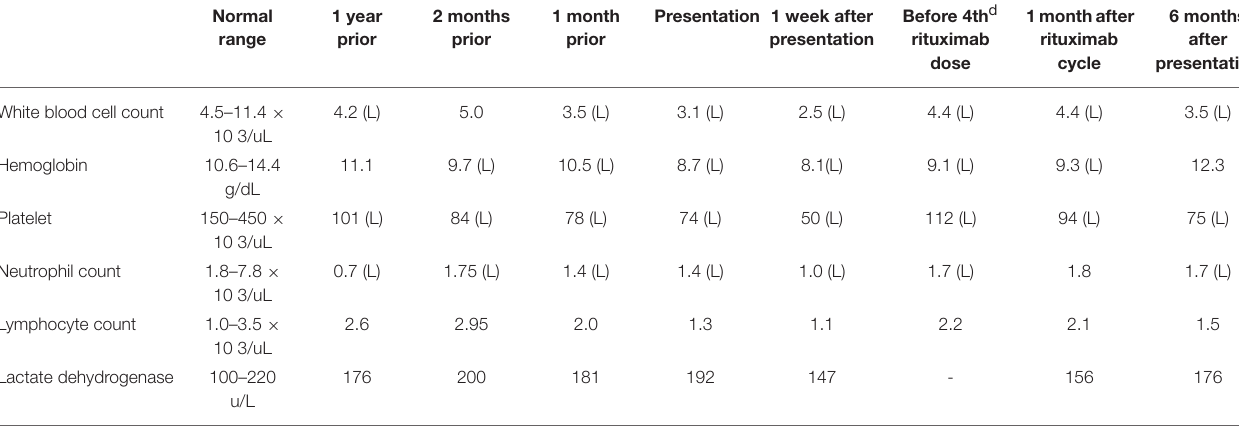
TABLE 1 | Clinical laboratory data